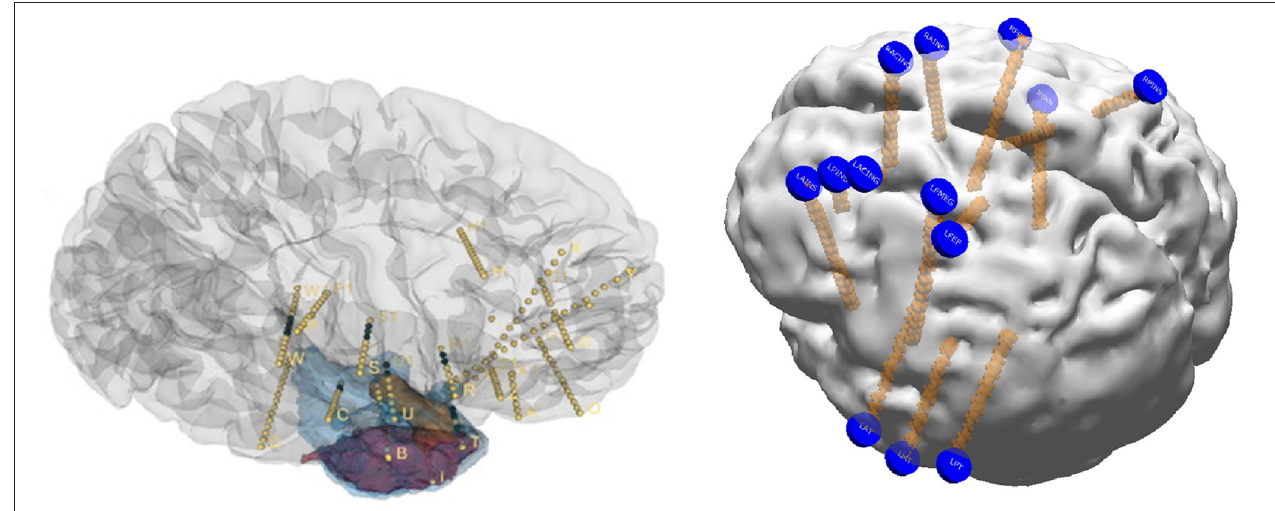
FIGURE 2 | Samples of reconstructed images from two different patients.